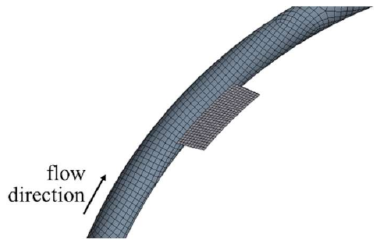
Figure 7. Computational grid for ring main and transfer box using ANSYS